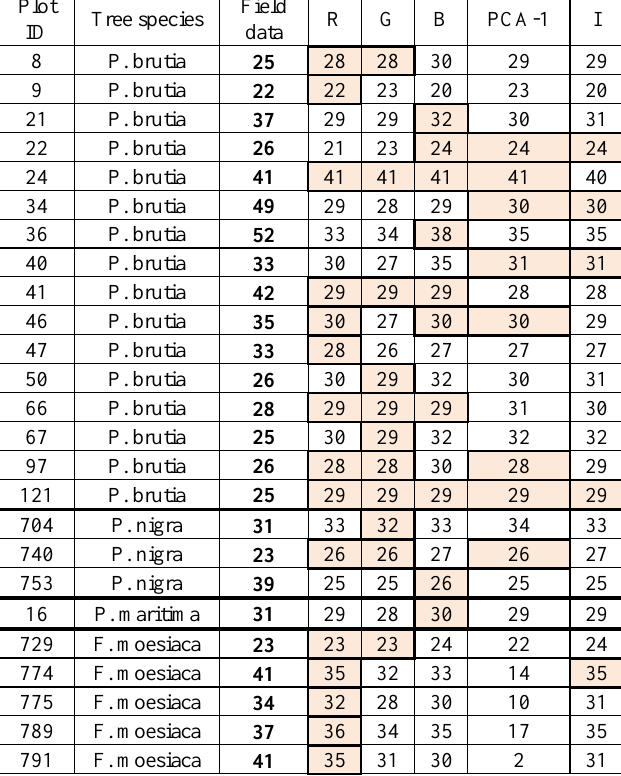
Table 1. The best performance in each plot is